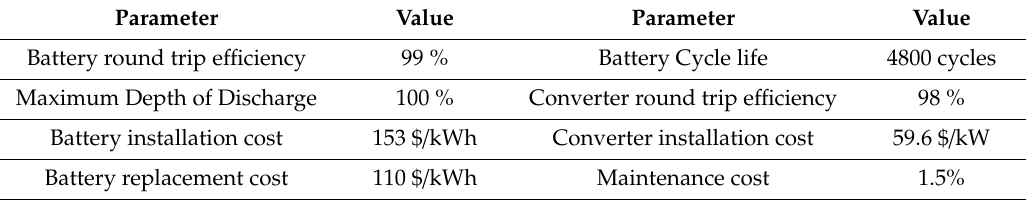
Table 3. EESS Data (data taken from [37]).